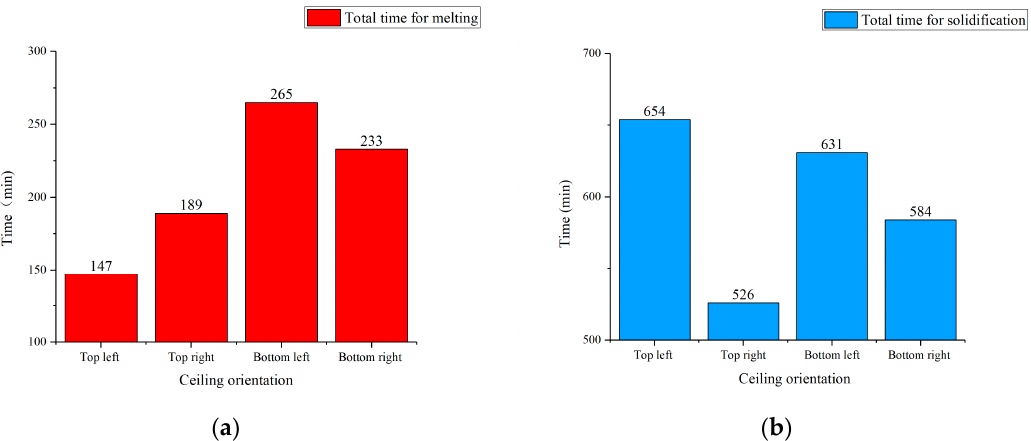
Figure 15. Total time of the phase transition process under Strategy 1: ( a ) Total time for melting; ( b ) Total time for solidification.